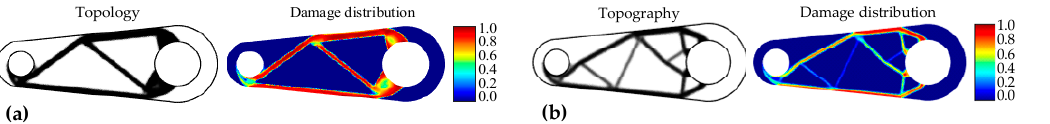
Figure 18. Optimal topology and damage distribution for a curved plate with circular holes: ( a ) P-norm constraint ( f = 0.266), ( b ) local constraint ( f = 0.208)